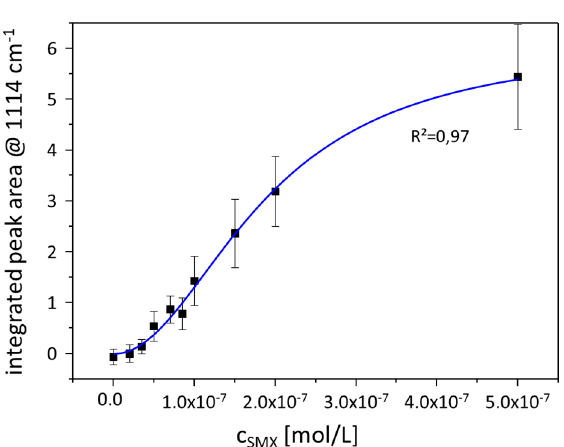
Figure 5. Correlation between the normalized peak area of the marker band at 1114 cm − 1 and the SMX concentration fitted with a Langmuir–Freundlich profile. The concentration values are identical with the values provided in Figure 3.